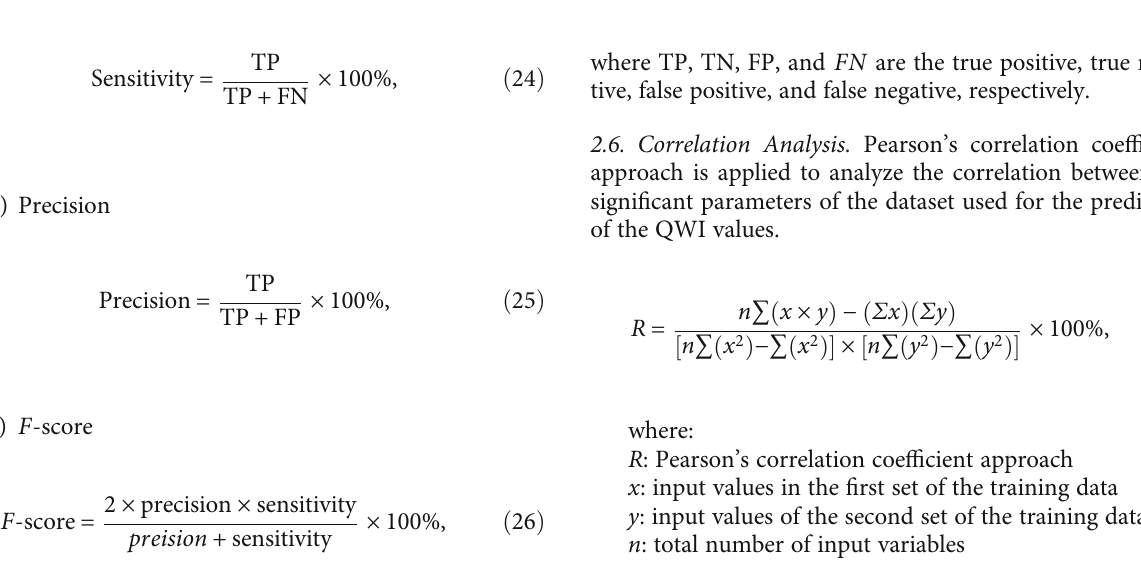
Figure 8: Regression plot of the NARNET